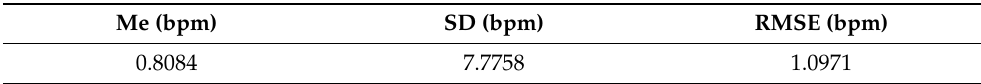
Table 1. Metric computation for heart